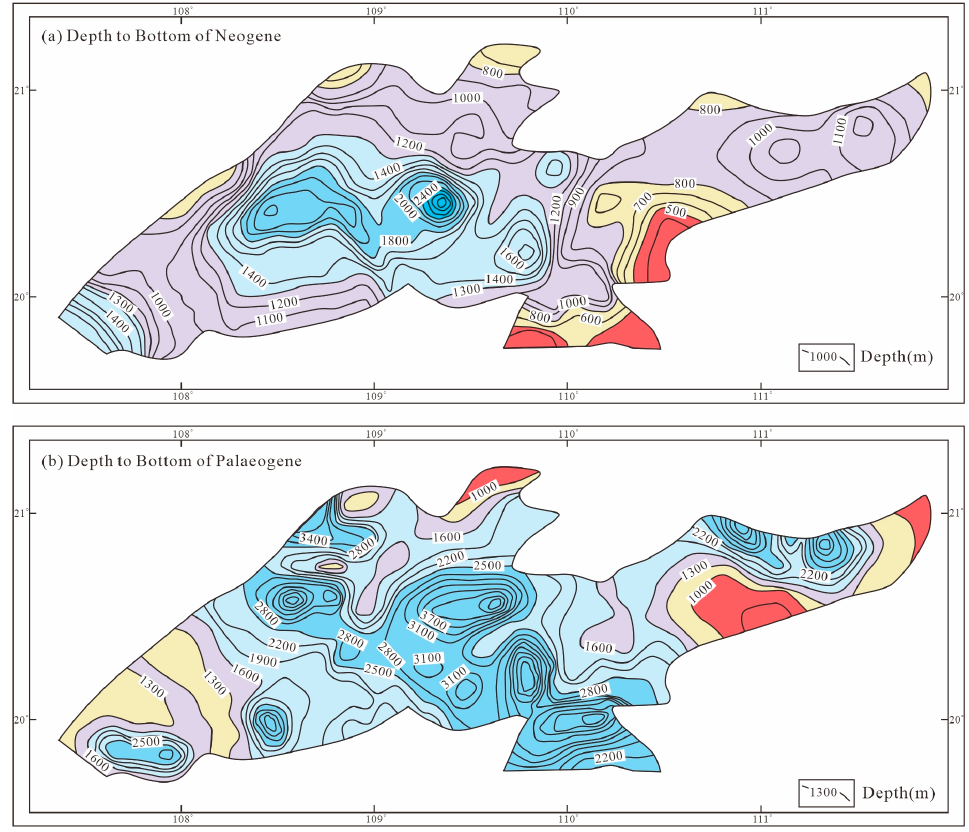
Figure 6. Burial depth map of Neogene ( a ) and Paleogene ( b ) strata in the Beibu Gulf Basin (modified after [28]).